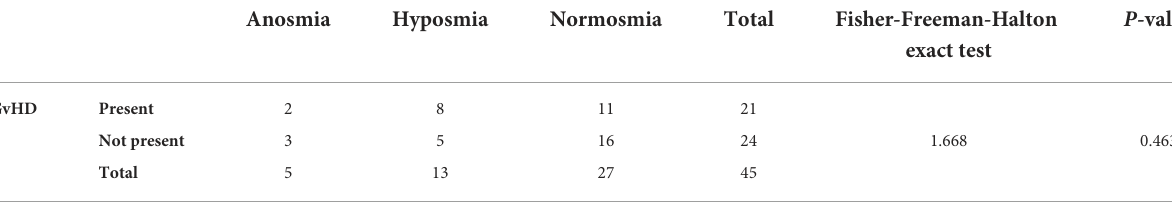
TABLE 4 Relation between oral mucosal cGvHD and smell sense.